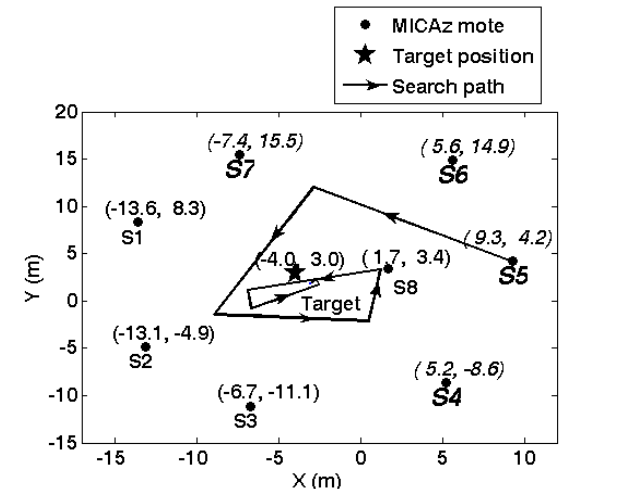
Figure 13. Vehicle localization by collaboration between s4, s5, s6 and